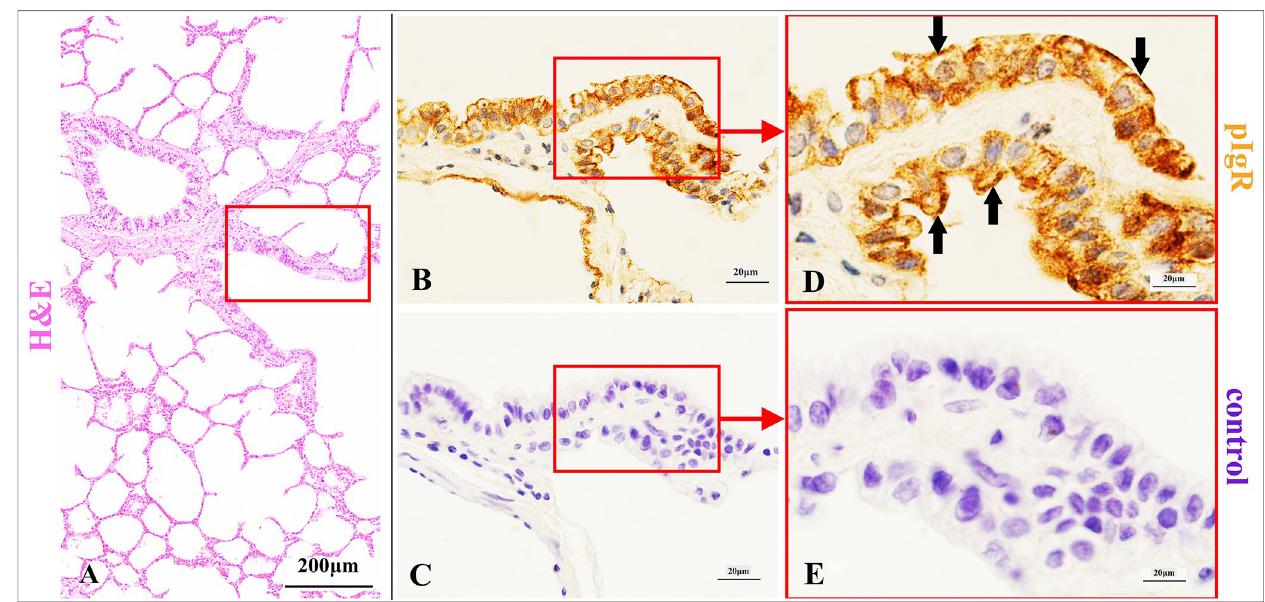
Fig 6. pIgR expression characteristics of respiratory bronchial epithelium in Bactrian camels.